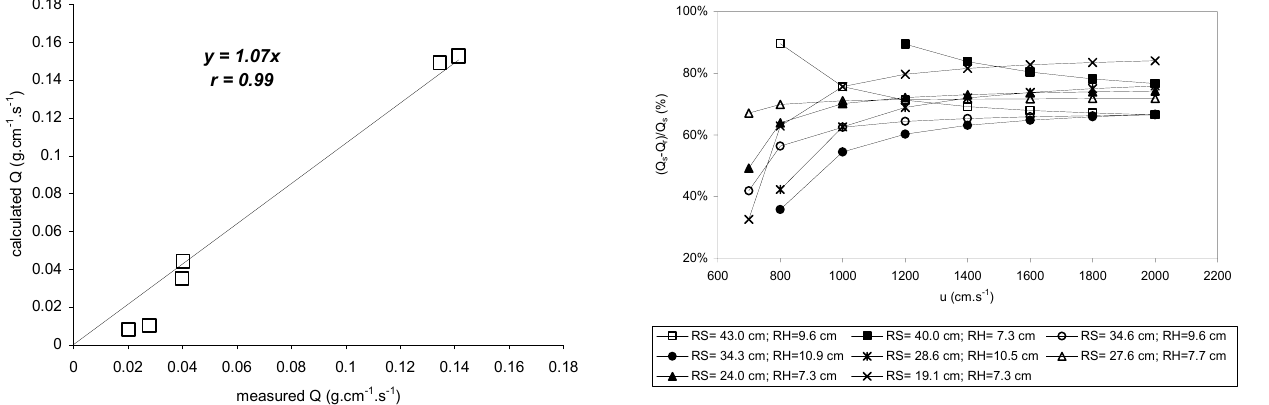
Fig. 9. Measured versus calculated fluxes for the unridged surface.